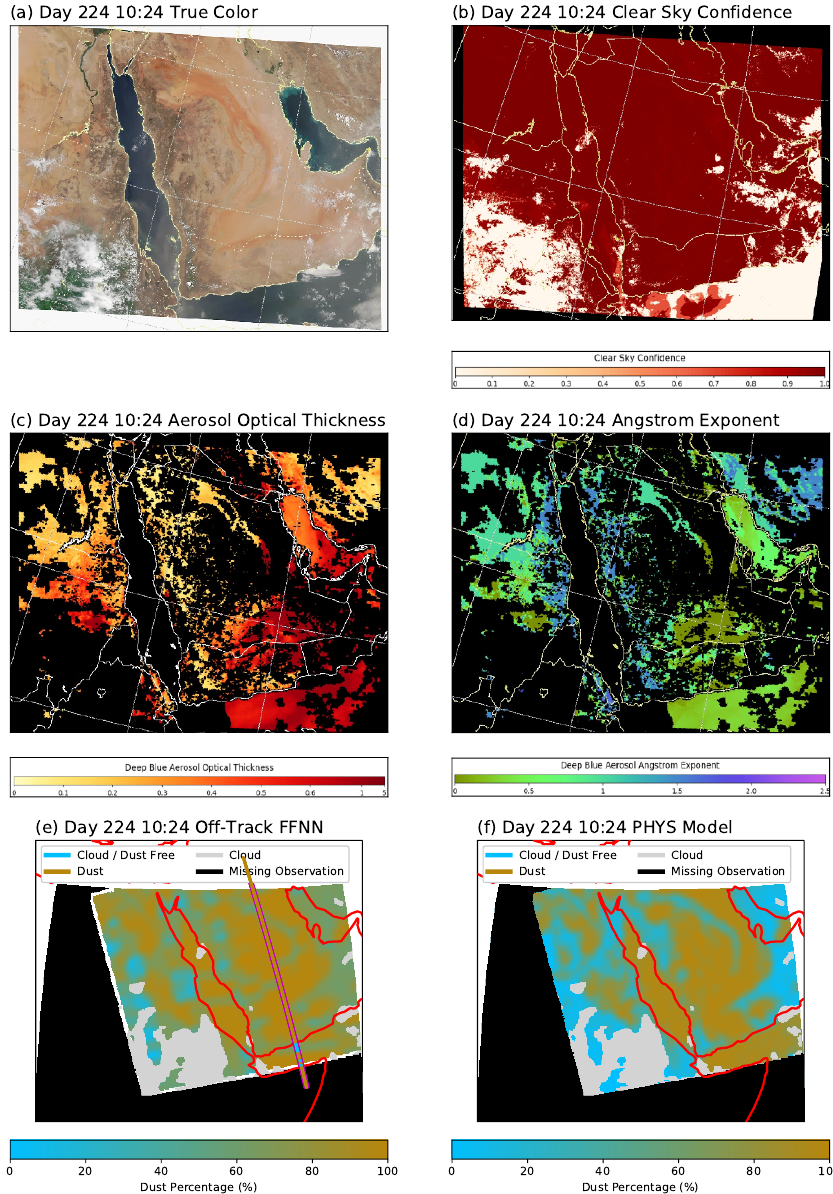
Figure 9. A case study over Arabian peninsular on day 224, at 10:24. ( a – d ) depict images from Wisconsin’s VIIRS quicklook, where ( a ) represents the true color, ( b ) Clear Sky confidence, ( c ) Aerosol Optical Thickness, and ( d ) Angström Exponent; ( e ) FFNN results in the same geolocation. Results are plotted in a 0.1 × 0.1 latitude and longitude grid, and the percentage of dust within the grid are shown as colors. Thin magenta lines show the CALIOP swath of this region. Pixels within the magenta lines are the CALIOP product. ( f ) same as ( e ), but for the PHYS